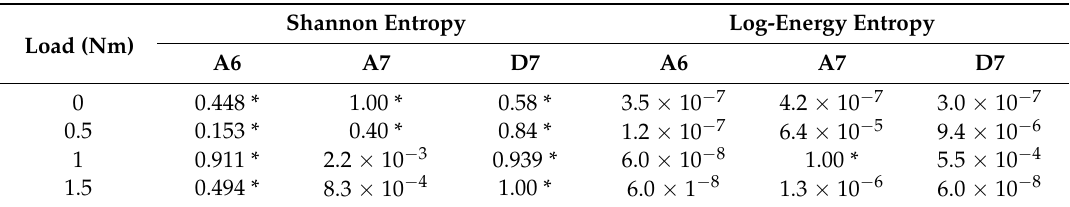
Table 5. p -Value calculation from the post-hoc test procedure for features in different sub-band frequencies. Shannon Entropy Load (Nm)